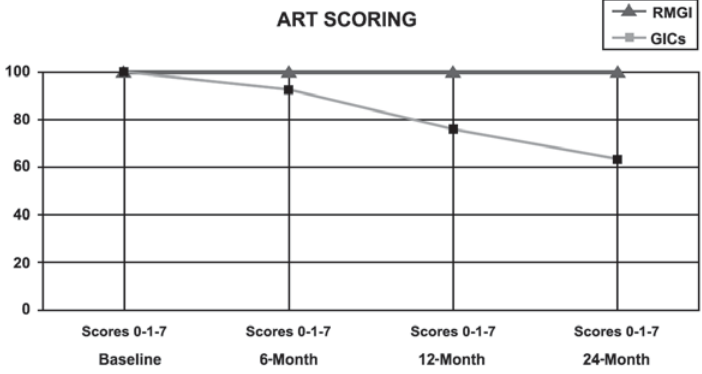
FIGURE 3- ART-scoring system success rate of GIC and RMGI material during the study period